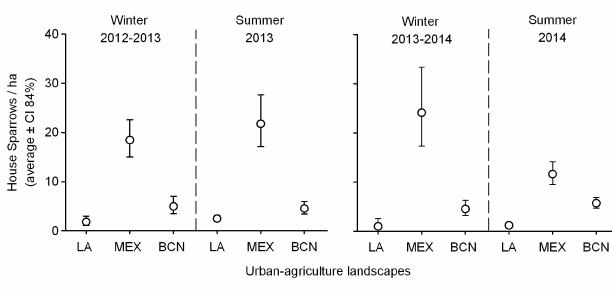
Fig. 2 . House Sparrow ( Passer domesticus ) distance-sampling corrected density estimations for Los Angeles, Mexico City, and Barcelona. To compare sparrow densities between cities, we considered two groups statistically different from one another when their 84% confidence intervals did not overlap, while we considered them not statistically different from one another when their confidence intervals did